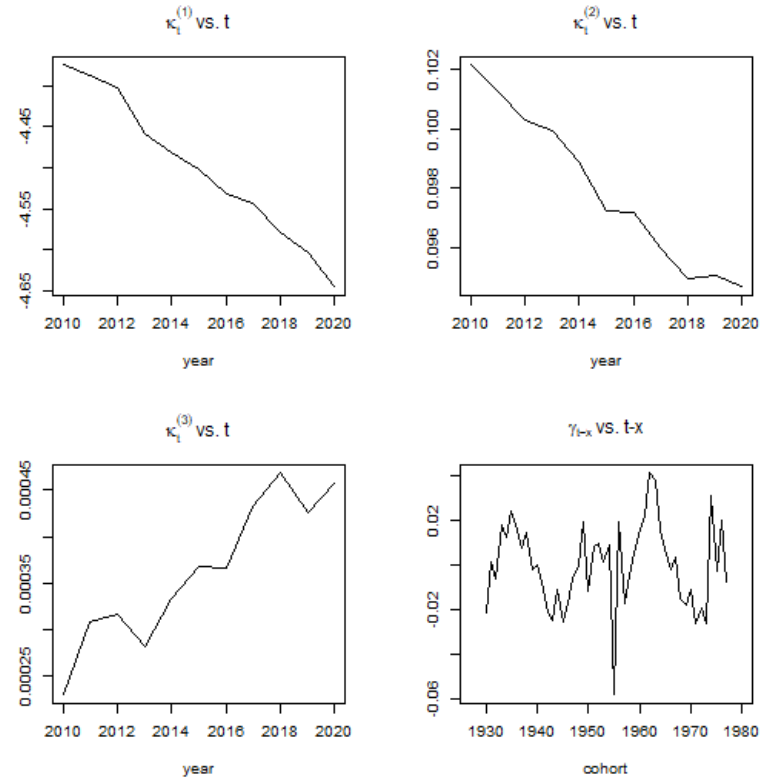
Figure 6. Quadratic CBD parameters Fitted to the Ghana Pension Population for Ages 40–83 and the Period